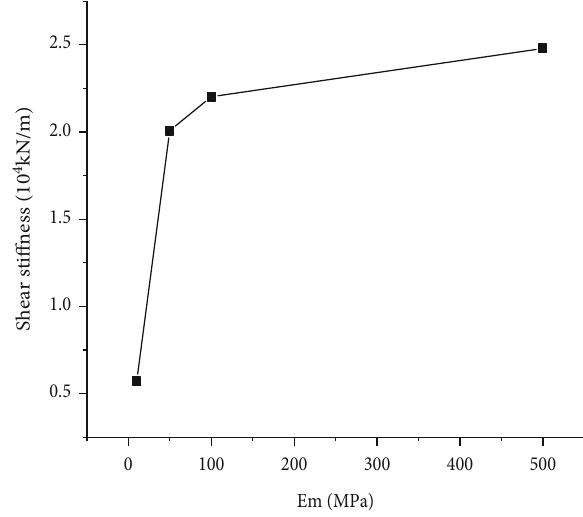
Figure 5: Shear sti ff ness of di ff erent E